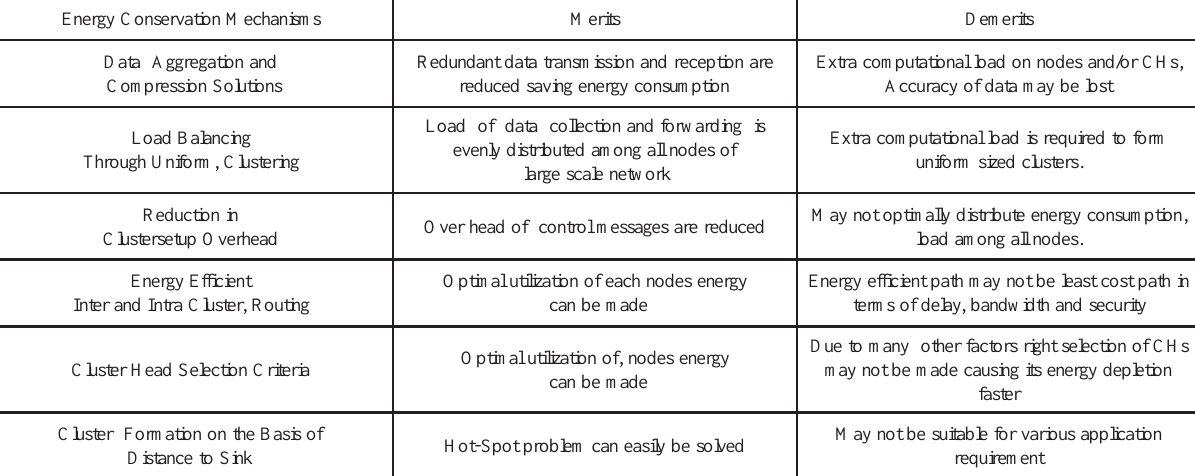
TABLE 3. MERITS AND DEMERITS OF ENERGY CONSERVATION MECHANISMS